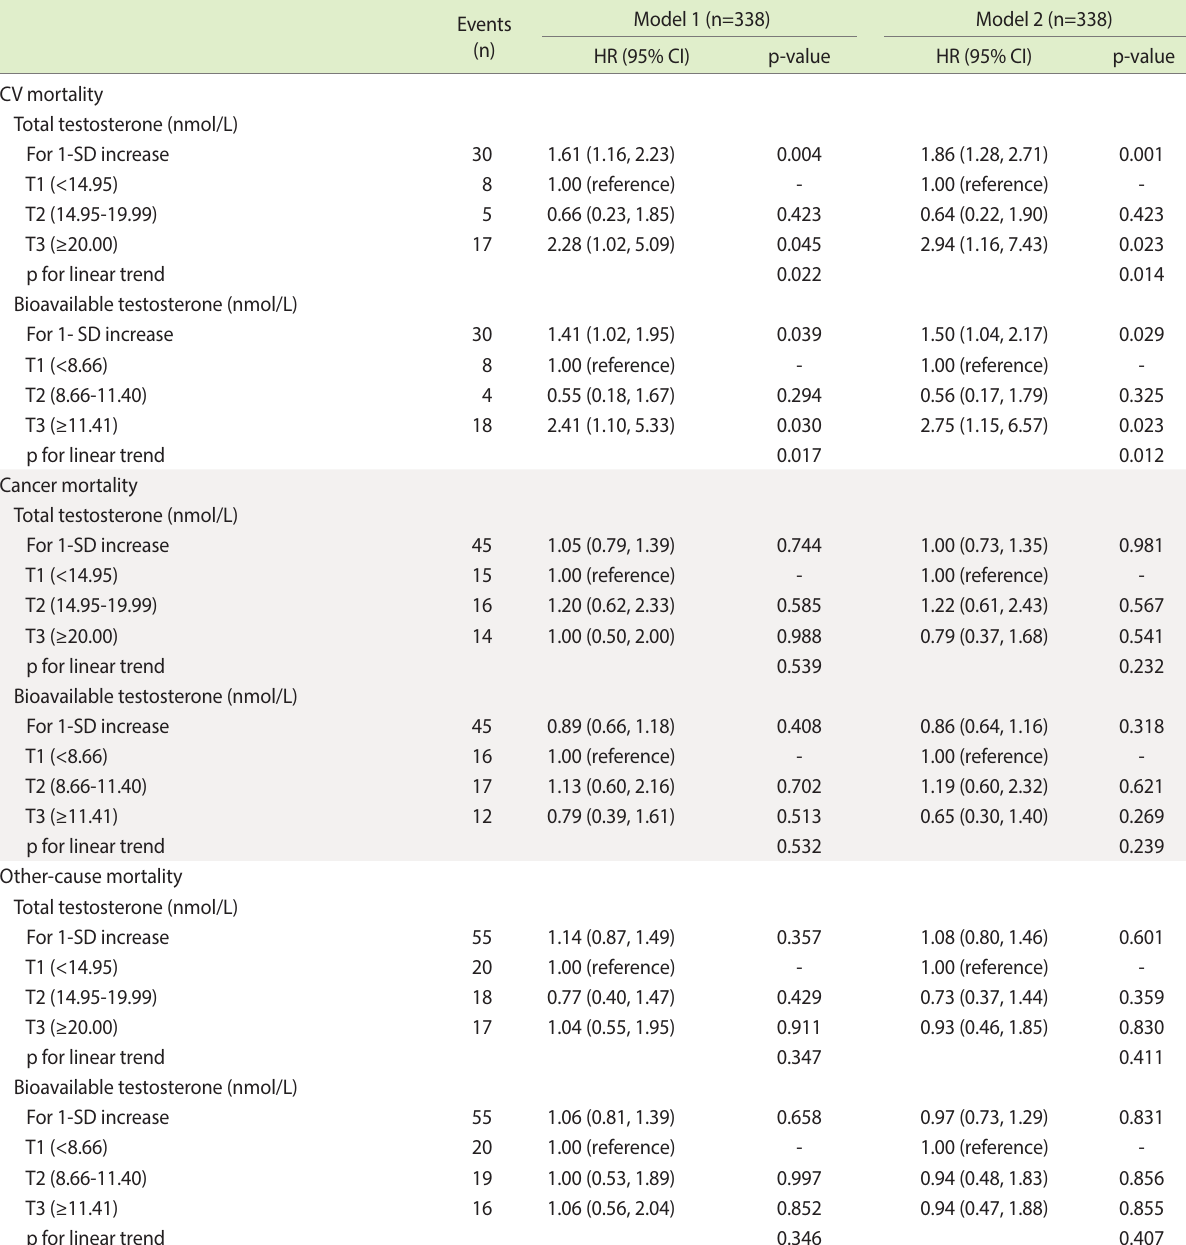
Table 2. Cause-specific mortality in men without MetS according to baseline testosterone levels